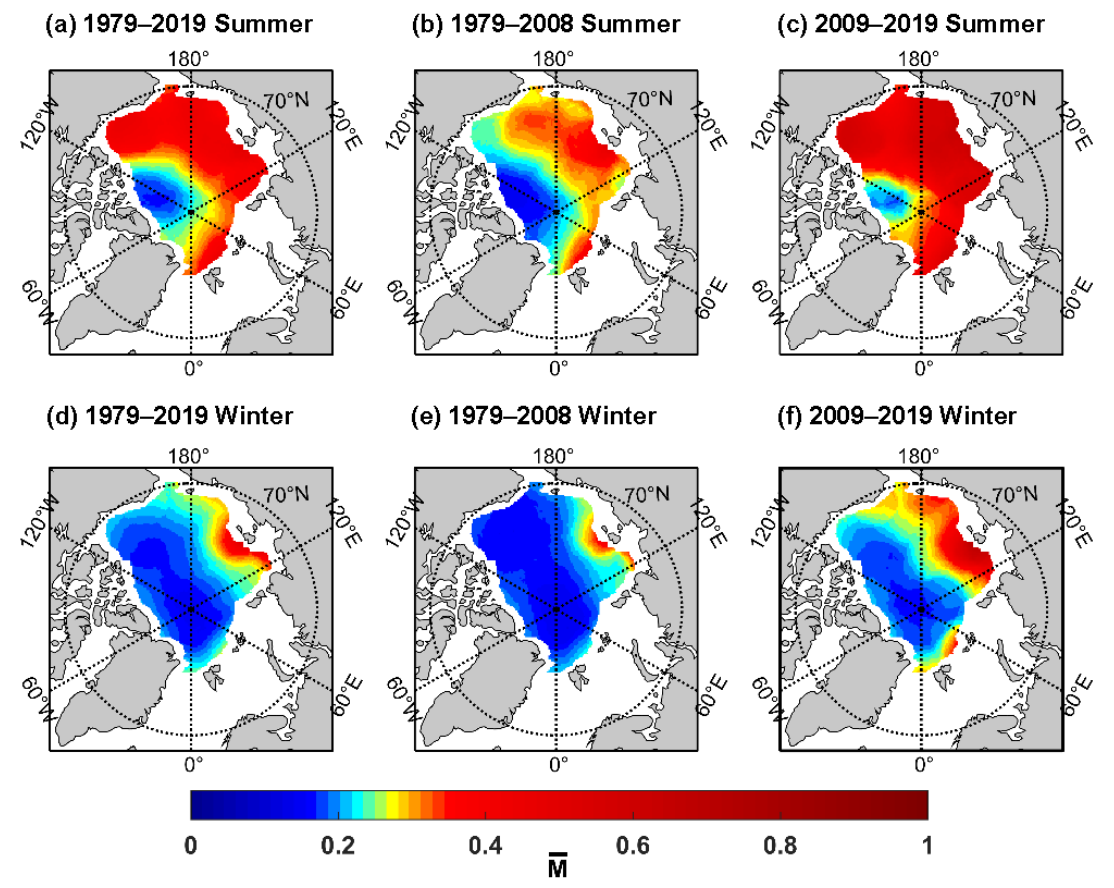
Figure 6. Spatial distributions of 𝑀̅ in summer (first row) and winter (second row) during ( a , d ) 1979 – 2019, ( b , e ) 1979 – 2008, ( c , f ) 2009 – 2019. The 𝑀̅ value for each grid is plotted only when the associated weight is greater than 1000.